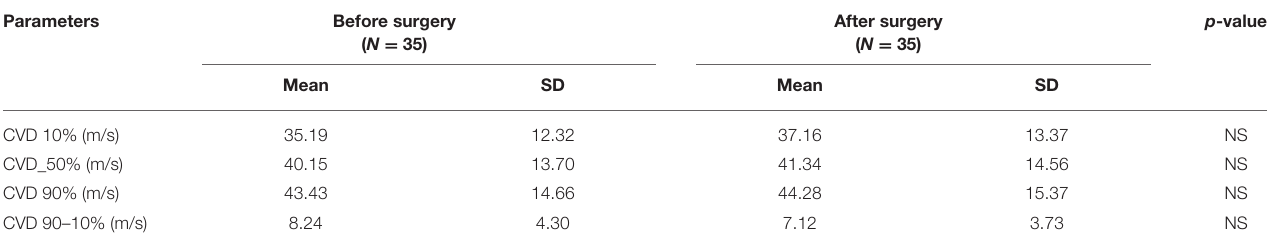
TABLE 2B | Comparison of CVD parameters in CTS patients after the surgery and in the control group. Parameters